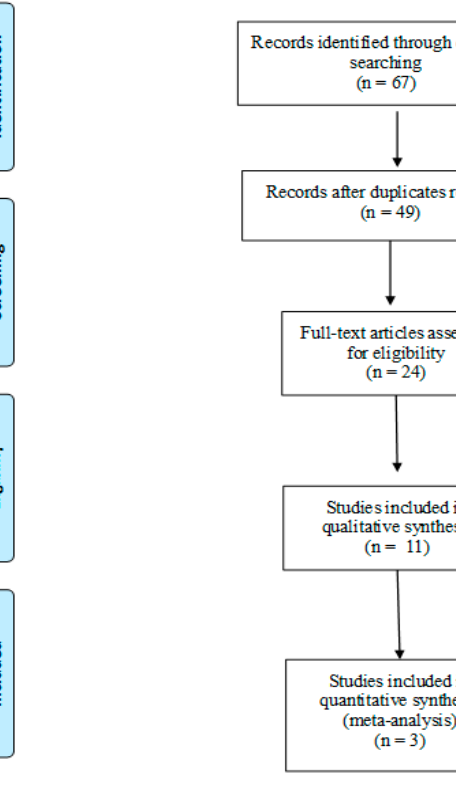
Figure 2. Flow diagram of study selection.